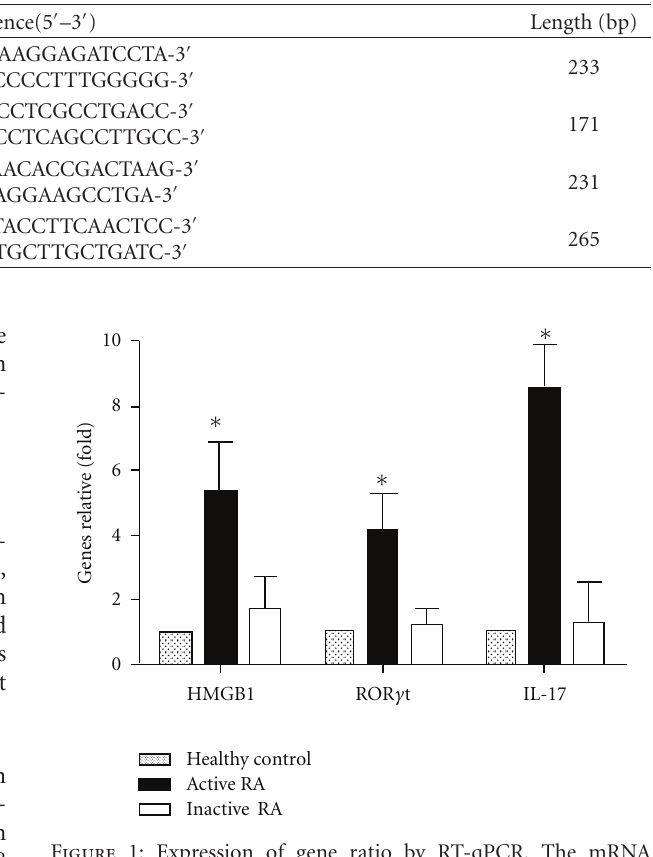
Figure 1: Expression of gene ratio by RT-qPCR. The mRNA expression level were determined by RT-qPCR, the values were expressed as the fold of the healthy control. the ratio of target genes used the healthy control as 1. ∗ P < 0.05 compared with the healthy control and inactive RA